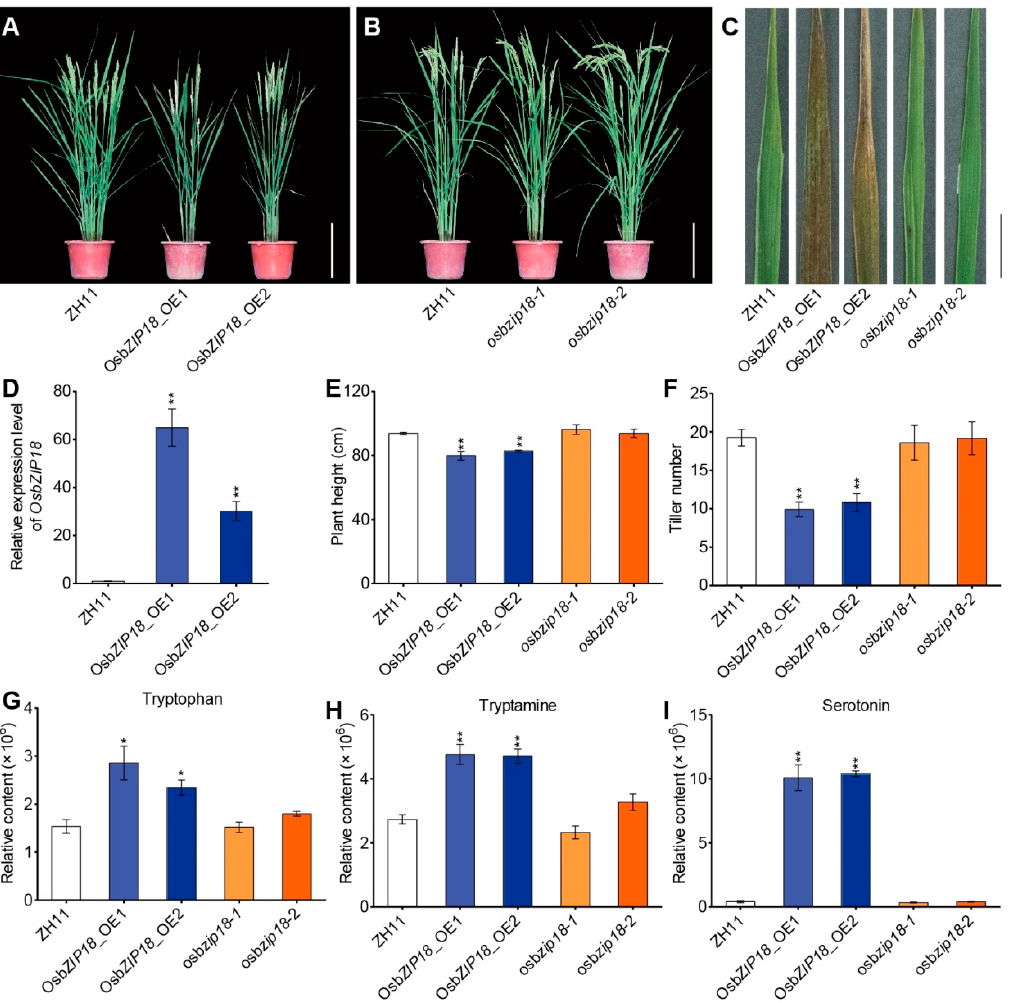
Figure 3. Appearance and serotonin biosynthesis of OsbZIP18 transgenic lines and their wild type (ZH11). ( A , B ) Phenotype of two OsbZIP18 -overexpression lines ( OsbZIP18 _OE1 and OsbZIP18 _OE2), two osbzip18 knockout mutants ( osbzip18-1 and osbzip18-2 ), and the wild-type rice (ZH11). The plants were cultivated in a paddy field in a tropical area (Lingshui, Hainan). ( C ) Appearance of the dark-brown pigmentation in the mature leaves. ( D ) Relative expression levels of OsbZIP18 in the leaves of the wild type (ZH11) and two independent overexpression lines. The ubiquitin gene was used as the endogenous control. ( E , F ) The plant height ( E ) and tiller number ( F ) in ( A , B ). ( G – I ) The accumulation of tryptophan ( G ), tryptamine ( H ), and serotonin ( I ) in the leaves. All data were compared with ZH11. Scale bars = 20 cm for ( A , B ) and 1 cm for ( C ). The p -value was calculated using Tukey’s test; n = 6 ( E , F ), n = 3 ( D , G – I ). * p < 0.05 and ** p < 0.01.